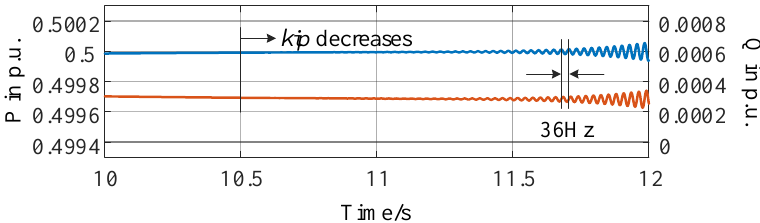
Figure 9. Simulation waveforms of active power and reactive power in p.u. in the VSG controlled converter when k ip decreases (blue lines, active power; orange lines, reactive power).